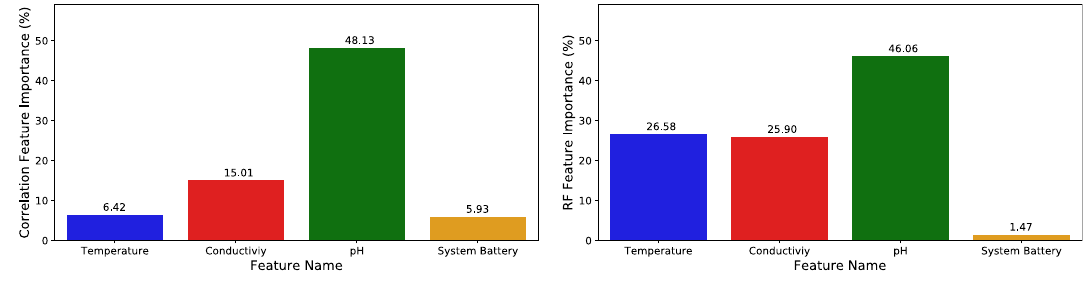
Figure 12. Feature importance of the original features for Chl- a prediction using linear (Pearson’s coefficient a ) and nonlinear (Random Forest Feature importance b ) calculations. Note that the percentage value of a feature can only be compared with respect to the other features in the same graph as each graph represents different